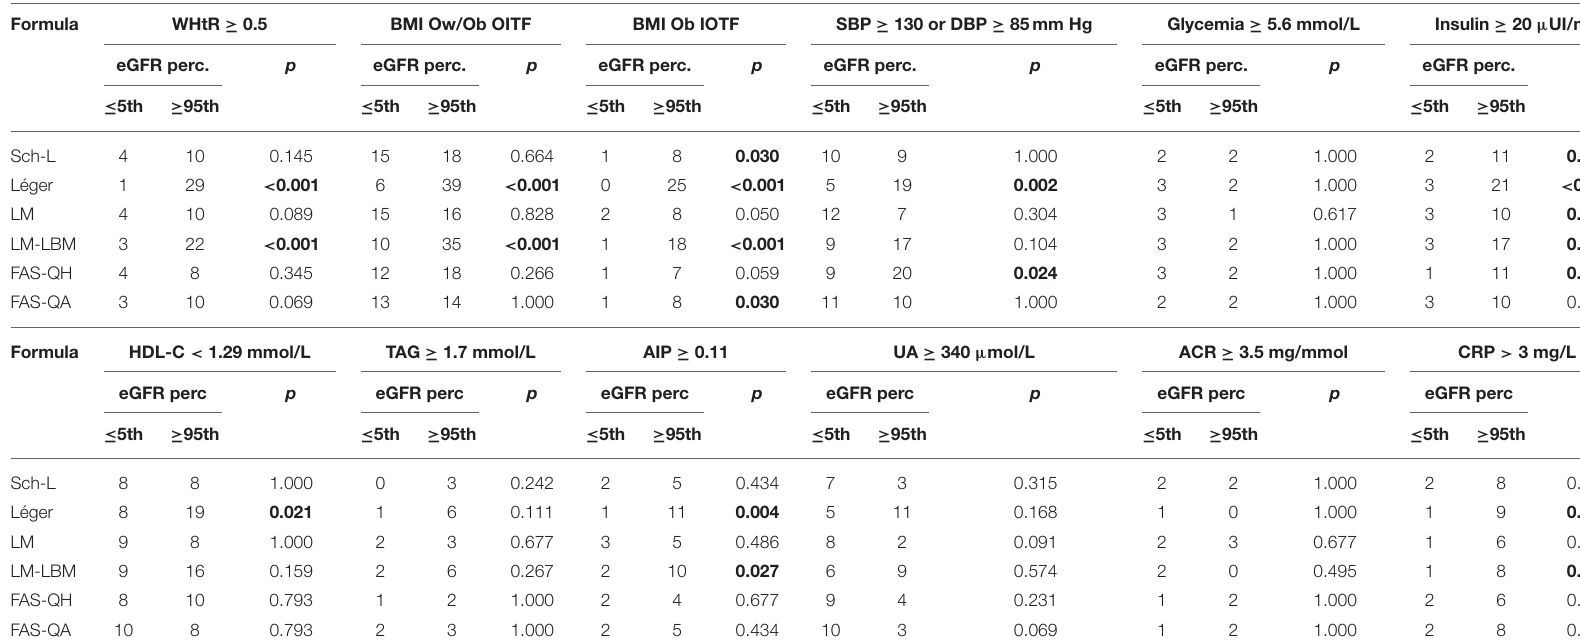
TABLE 6 | The prevalence of cardiometabolic risk factors in males with estimated glomerular filtration rate ≤ 5th vs. that of ≥ 95th according to six creatinine-based